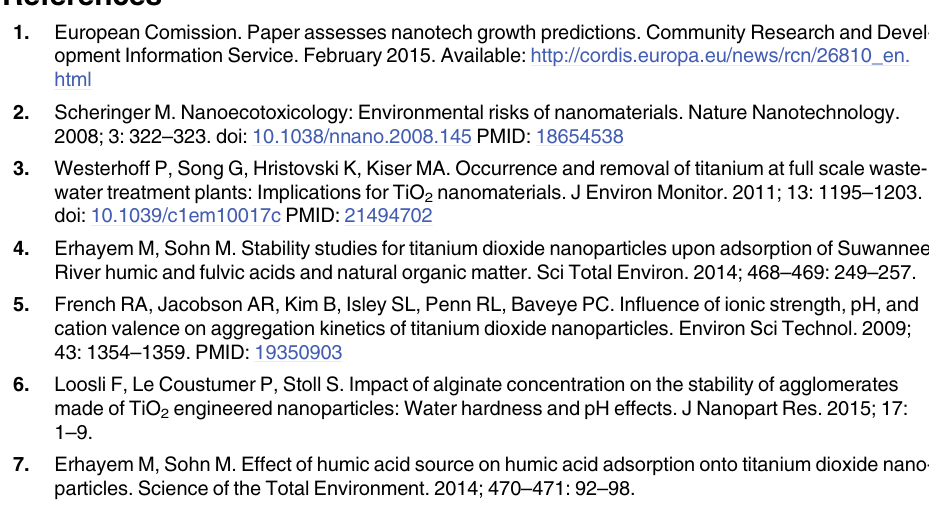
S7 Fig. Cumulative median (± SD) reproduction per test-organism after 21 d of exposure to differently aged nTiO . (A) Animals exposed to nTiO aged for 0 d in ASTM without 2 2 aged for 3 d in ASTM without NOM ( □ ). (C) Ani- NOM ( (cid:1) ). (B) Animals exposed to nTiO 2 aged for 0 d in ASTM with NOM ( ● ). (D) Animals exposed to nTiO mals exposed to nTiO 2 2 aged for 3 d in ASTM with NOM ( & ). Asterisks denote statistical significant difference relative to the respective control; p < 0.05 ( (cid:3) ), p < 0.01 ( (cid:3)(cid:3) ). NA indicates a not assessable reproductive output due to 100% mortality of adult daphnids in the respective treatment. S1 Table. Composition and ionic strength of the ASTM test medium. S2 Table. Dissolved organic carbon analysis ( μ g/L-C; if not stated otherwise) for seaweed extract (SW) applying SEC-OCD-OND (size-exclusion chromatography — organic carbon detection — organic nitrogen detection. S3 Table. Mean (± SE; n = 3) water quality parameters measured over the entire test dura- tion of each Daphnia reproduction experiment. S4 Table. Model specification and respective Akaike's information criterion on which each value is 96-h EC 50